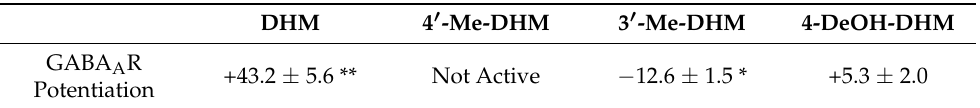
Table 2. Intrinsic GABA A R activity of DHM, 4 ′ -Me-DHM, 3 ′ -Me-DHM and 4 ′ -DeOH-DHM in α 5 β 3 γ 2 expressed in Xenopus oocytes in the presence of GABA.